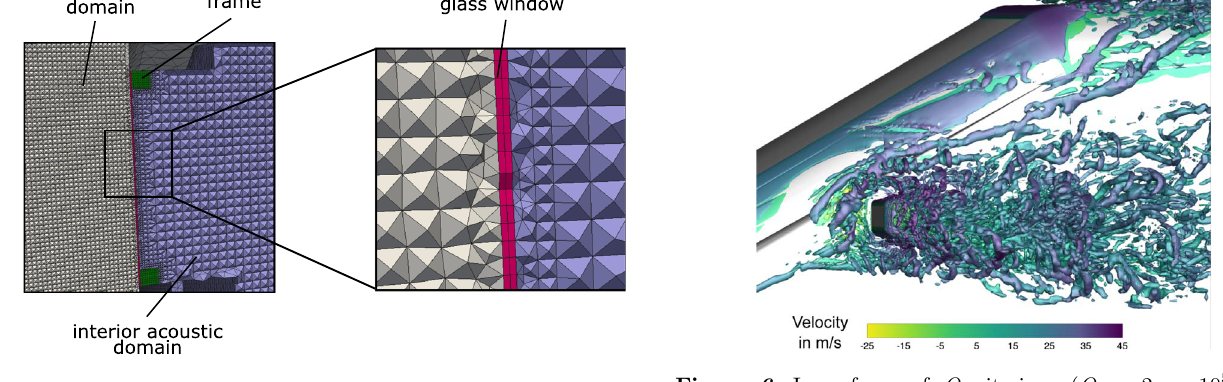
Figure 5. Section of acoustic grid in near window area. Figure 6. Isosurfaces of Q -criterium ( Q = 2 (cid:4) 10 5 1/s 2 ) coloured by velocity